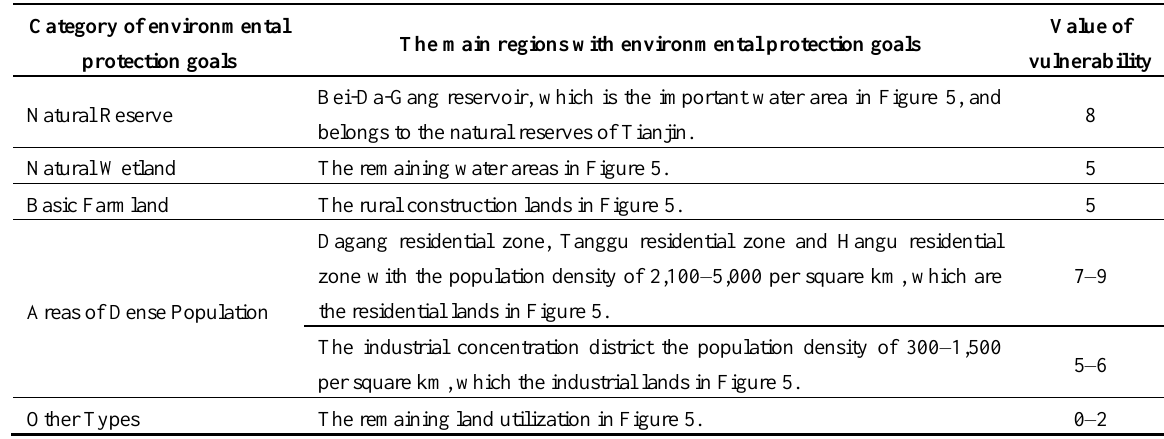
Table 4. The results of vulnerability assessment in Tianjin Binhai New